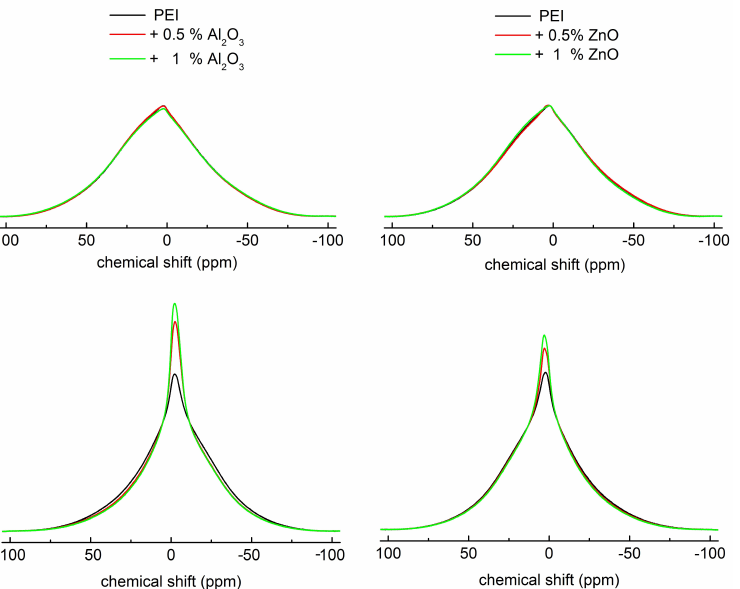
Figure 2. The BL 1 H NMR spectra of pure PEI and its mixtures with Al 2 O 3 or ZnO nanoparticles measured at ambient temperature ( upper row ) and 90 ◦ C ( lower row